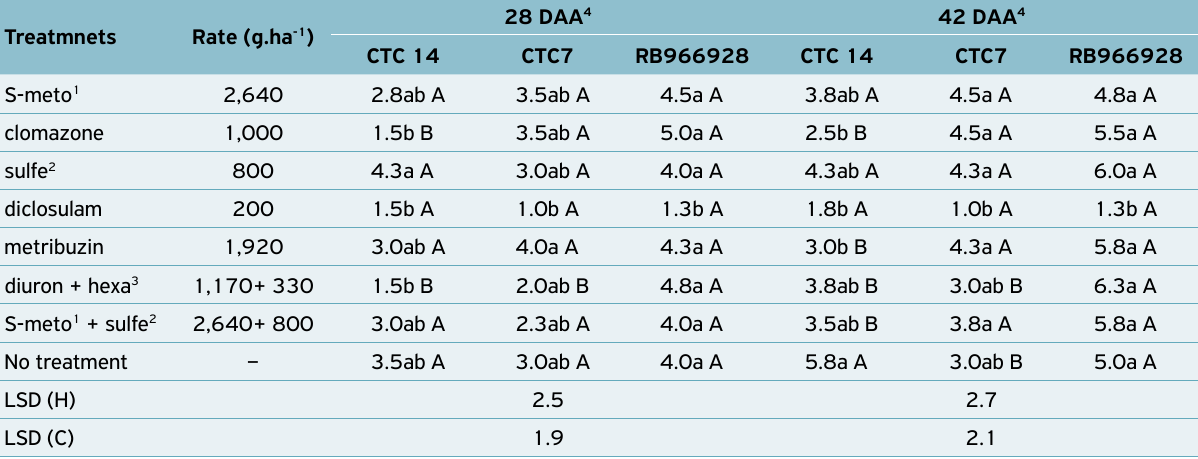
Table 5. Mean values of the number of tillers in the interaction between three sugar cane cultivars and different herbicides applied in pre-planting. Pradópolis, state of São Paulo, Brazil, 2013. Treatmnets